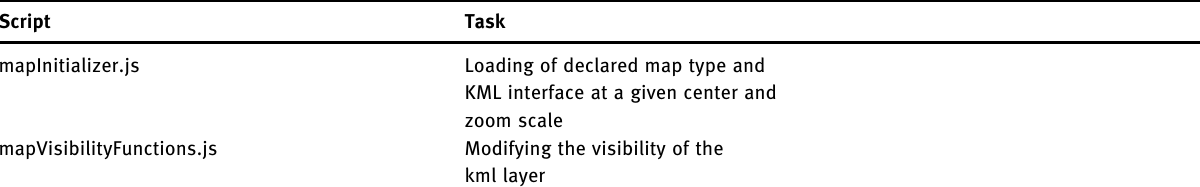
Table 2: Description of scripts of the Google API of the database table